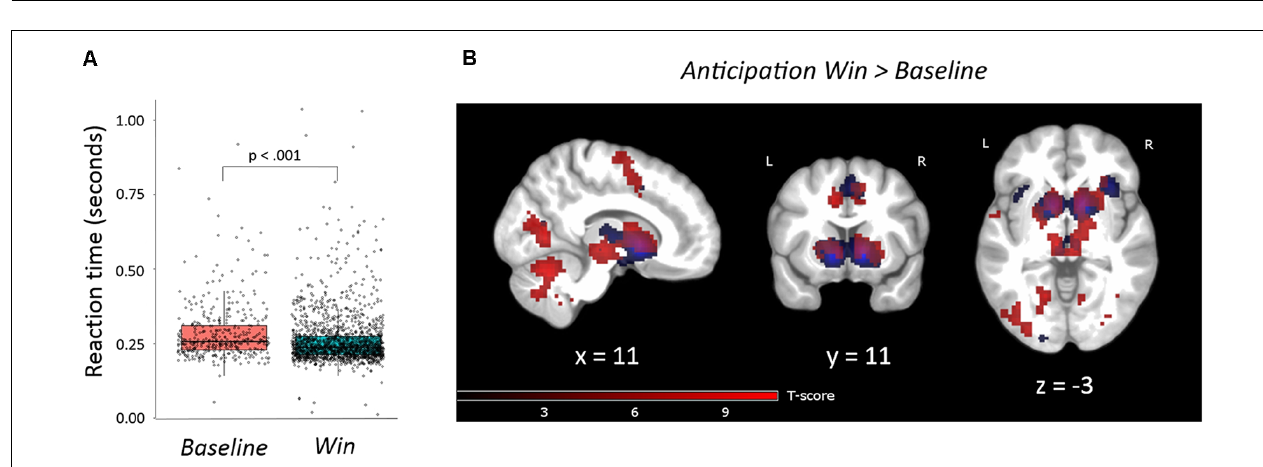
RT (M RTWin = 0.26 s (s), SD = 0.05); M RTBaseline = 0.29